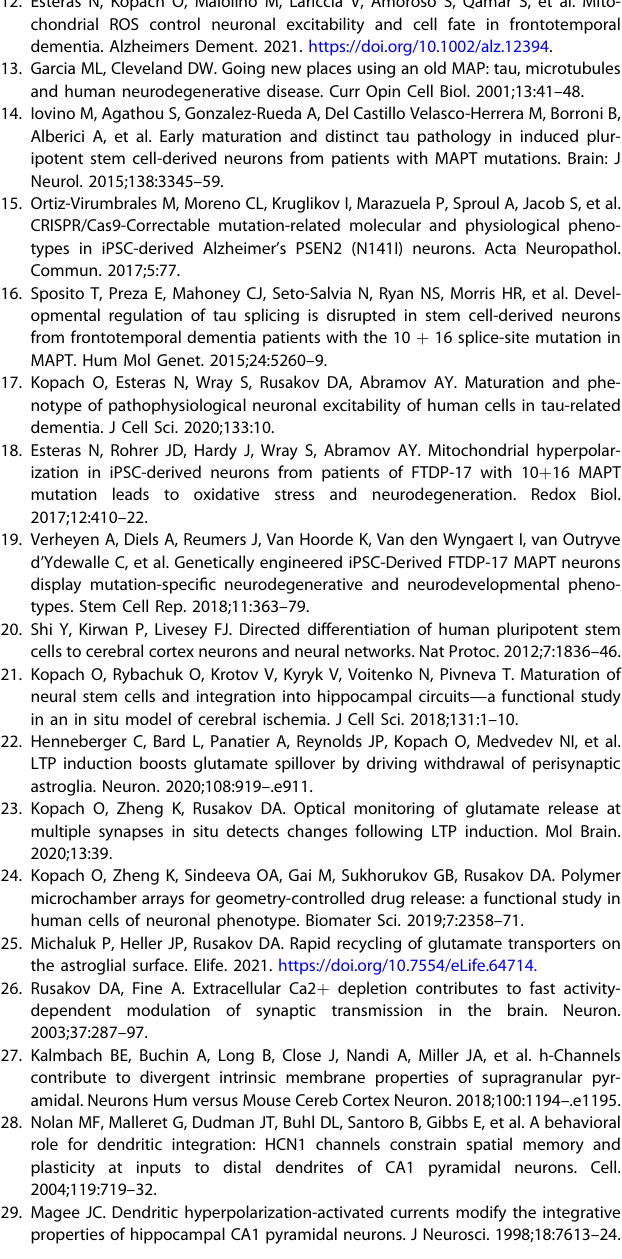
Fig. 6 4R tau impairs the intracellular Ca 2 + mobilization across neuronal compartments upon depolarization. A Monitoring of depolarization-induced intracellular Ca 2 + dynamics using two-photon excitation time-lapse imaging in control (wild type, wt, tau) iPSC- derived neurons (~210 DIV). Images, experimental arrangement for focal application of a high-potassium medium (50 mM) through a micropipette positioned in close proximity of the cells before (left panel) and during a puff of K + (right panel). Images, combined transmitted light, OGB-1 (green), and Alexa Fluor-594 (red) channels (upper row) and OGB-1 only (lower row); λ 2P ex = 800 nm; dotted areas, regions of interest (ROI): cells 1 – 2 and two neurites, d1 and d2. Plots, the time course of the intracellular Ca 2 + rise ( Δ F / F 0 OGB-1 signal) within indicated ROIs before and following cell depolarization; top trace, Alexa Fluor-594 diffusion pro fi le across the fi eld of view; red arrow, timestamp of K + puff. B Notations as in ( A ) but for the MAPT IVS10 + 16 group. Note the slow and diminished depolarization-induced Ca 2 + -rise ( Δ F / F 0 OGB-1 signal), with prolonged decay kinetics, in soma and neurites. C Quanti fi cation of the peak Ca 2 + -rise ( Δ F / F 0 OGB-1 signal) in response to the two consecutive applications of K + medium in individual neurons from control (wt tau, n = 17 cells, left bars) and MAPT IVS10 + 16 groups ( n = 34, right). Boxes show median values. The nonparametric paired-sample Wilcoxon signed rank test indicated. D Statistics for the depolarization-induced Ca 2 + -rise ( Δ F / F 0 OGB-1 signal) for pooled groups of wt tau and MAPT IVS10 + 16 neurons recorded in soma (bars show median values, n = 89 cells and 88 cells, respectively, three independent preparations) and within neuronal processes (mean ± SEM, n = 10 per group). *** p < 0.001 nonparametric Mann – Whitney test; ### p < 0.001 ANOVA